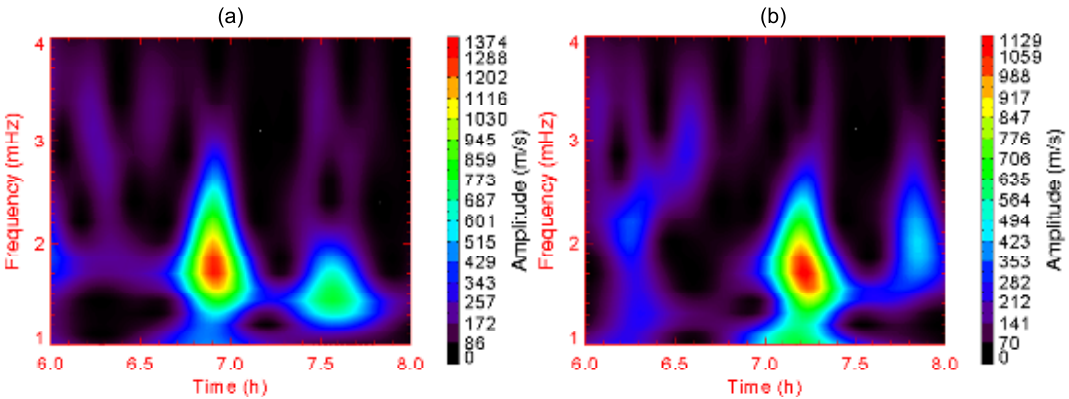
Fig. 7. The wavelet amplitude spectra of the x-component of the velocity data collected by instruments onboard the WIND satellite. Panels (a) and (b) show the 1.9mHz component observed at about 6.9h form the non-shifted data (CDAweb data) and at 7.3h from the time-shifted data (OMNI data) respectively. The amplitudes have arbitrary units.